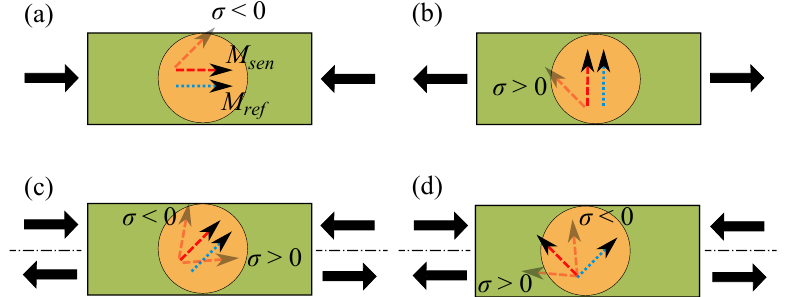
Figure 1. Different configurations of the easy axes of the sense and reference layers with respect to the stress axis leading to the detection of ( a ) compressive stress σ < 0; ( b ) tensile stress σ > 0; ( c ) compressive and tensile stresses and ( d ) compressive and tensile stresses with knowledge of the stress type. M sen (dashed red arrow) and M ref (dotted blue arrow) stand for the magnetization of the sense and reference layers, respectively. The orange circle shows a TMR sensor from the top placed on a cantilever (green rectangle). The black arrows indicate compressive and tensile